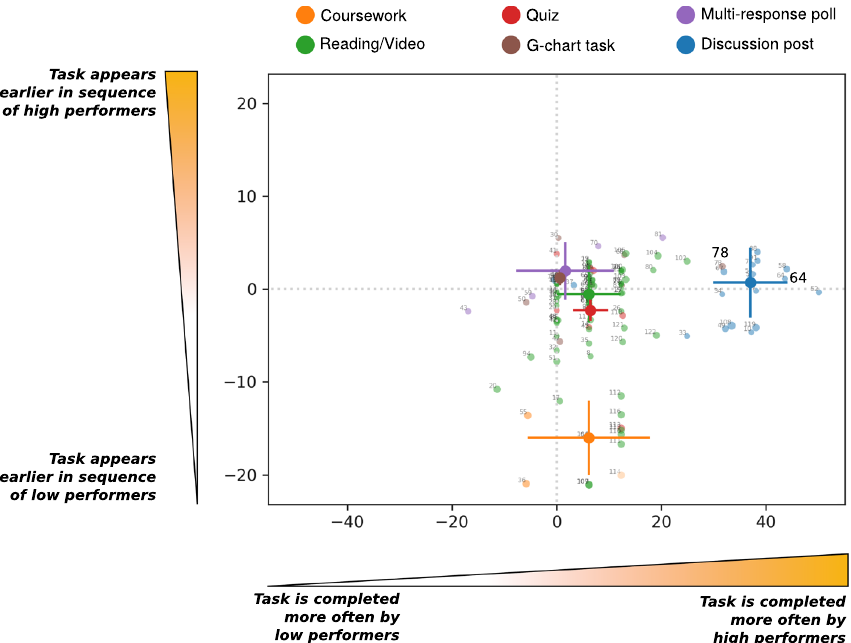
Figure 8. Comparing the high and low performing groups: The difference between the two groups in completion frequency versus the difference between the two groups in mean completion order. The tasks are identified by their task ID and colored by type (the six types are listed in the legend). For each task type, the median and inter-quartile range is plotted. If a task appears in the upper half, the task has been completed earlier on average by the group of high performers. If a task is located in the right half, the task has been completed more frequently by the group of high performers. Discussion posts, multi-response polls and G-chart tasks are completed significantly earlier and more frequently by high performers suggesting the importance of active learning. Coursework tasks appear earlier in the sequence of low performers because low performers have completed less of the course by the time the coursework is due for